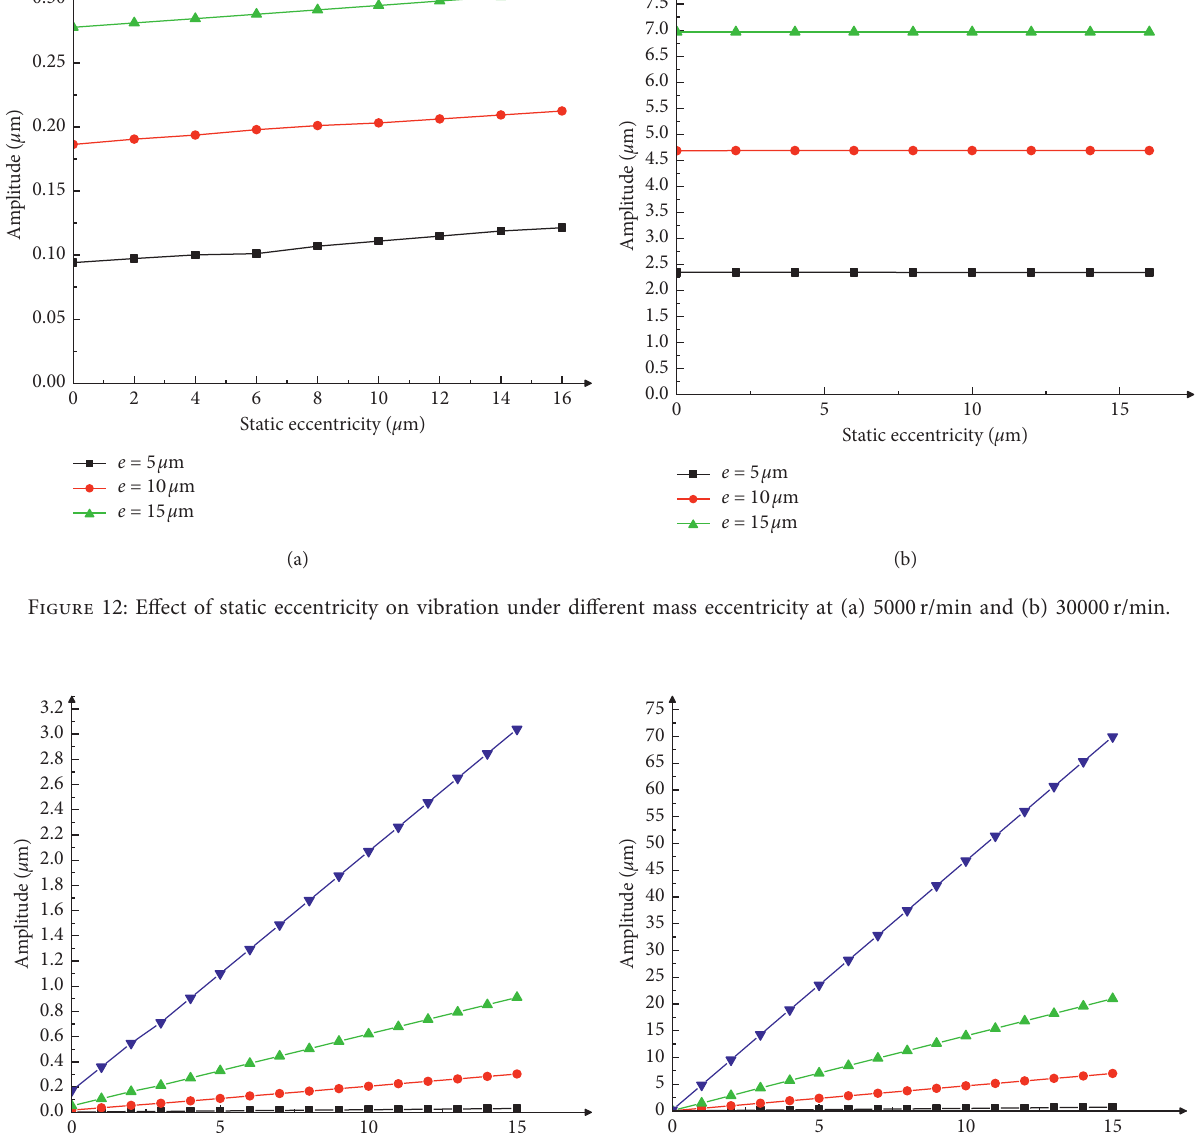
Figure 13: Effect of mass eccentricity on vibration at the rotating speed of (a) 5000r/min and (b)